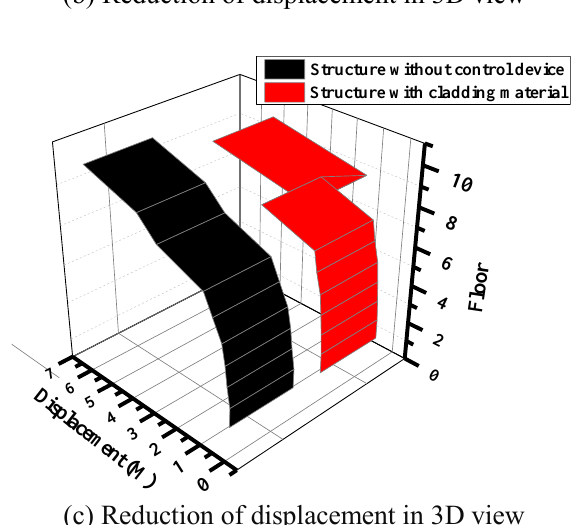
Fig. 10. Reduction of displacement of a structural system by cladding